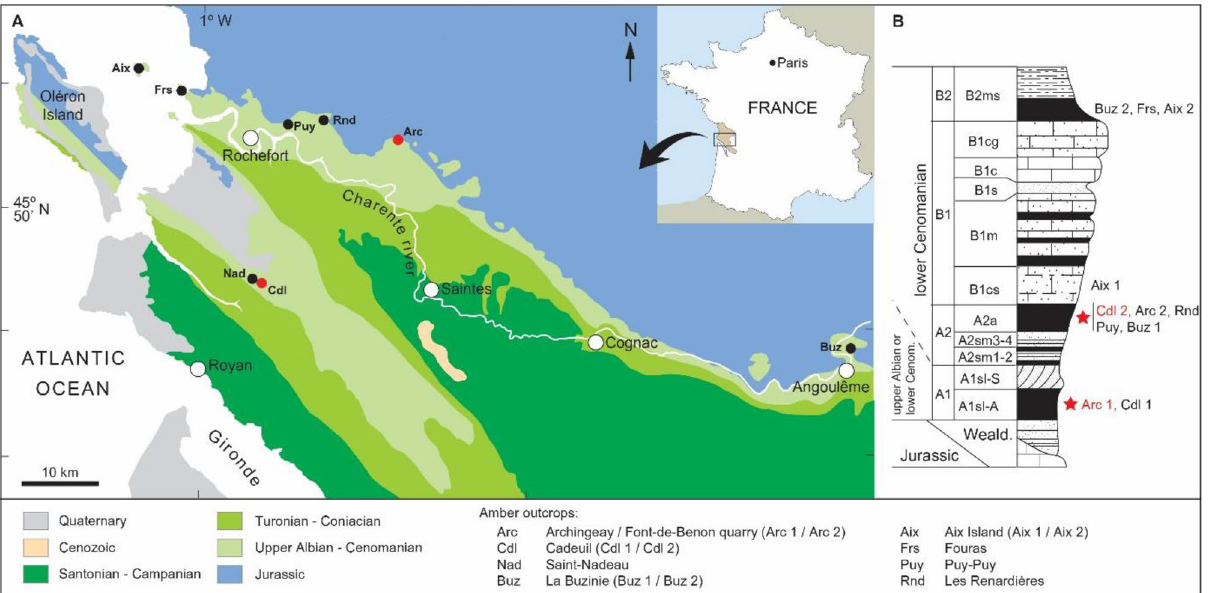
Figure 1. Geographical and geological setting of the Cretaceous Charentese amber deposits (modified from Perrichot et al. 27 ). ( A ) simplified geological map with indication of amber localities; ( B ) synthetic regional stratigraphic section with indication of amber outcrops. Red dots and stars denote the outcrops yielding Antodicranomyia species considered in the present study.